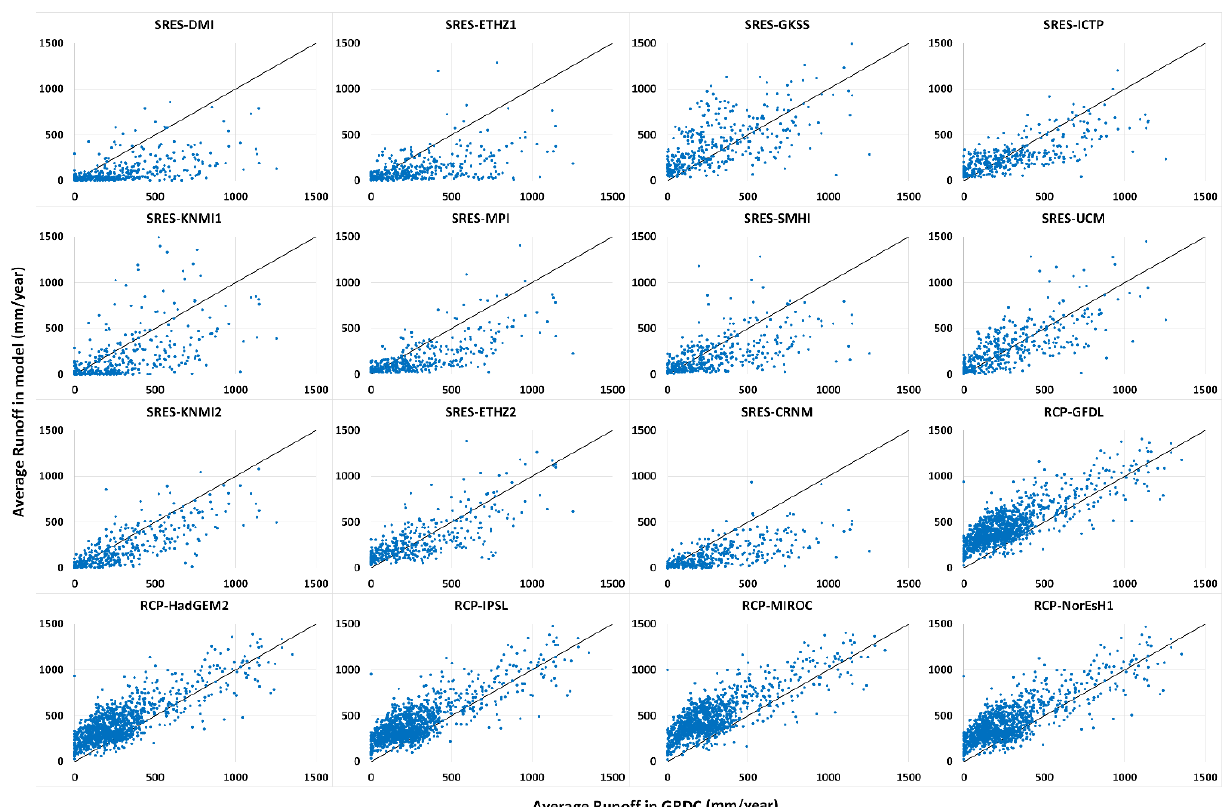
Figure 3. Comparison of mean annual runoff in catchments produced from the Global Runoff Data Set (GRDC) dataset with that produced by model runs for the historical period.